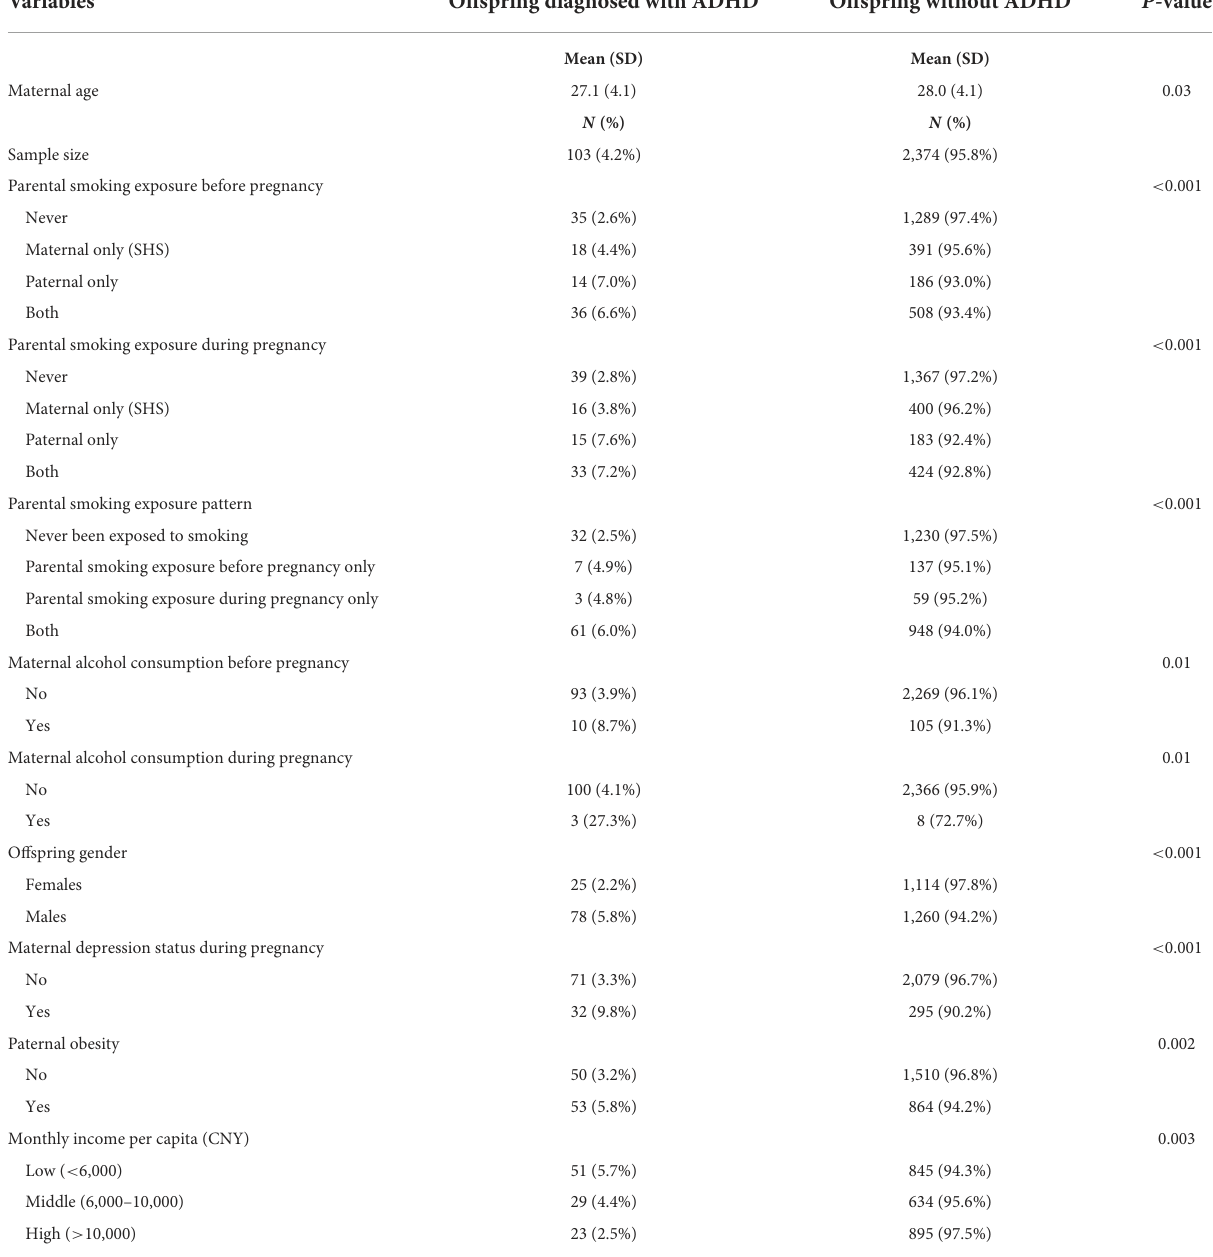
TABLE 1 The baseline characteristics of offspring and their parents participated in this study.